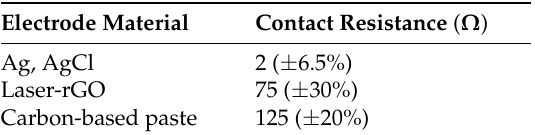
Table 3. Values of the contact resistance, R c , extracted from different material-based